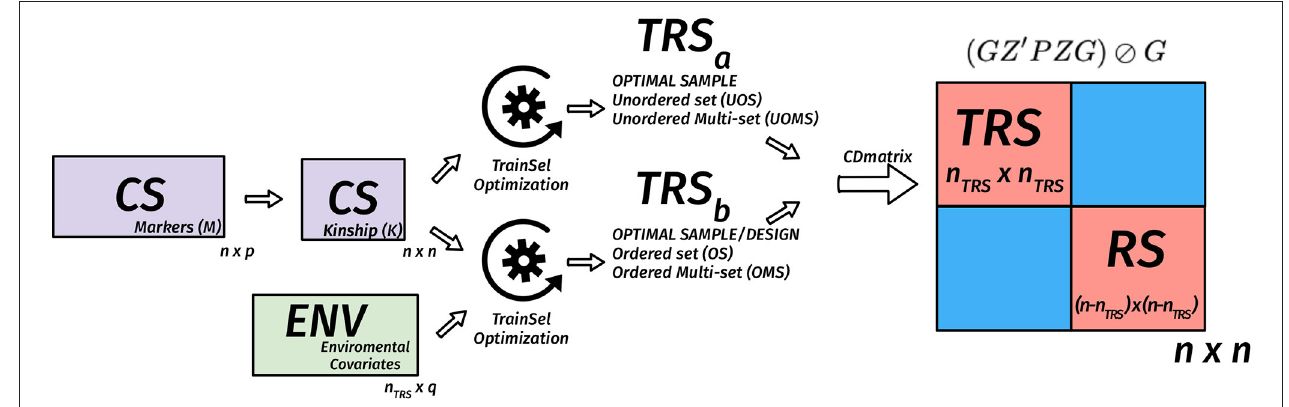
FIGURE 2 | Diagram of the matrix of the coefficient of determination (CD) criterion in the TRS optimization for unordered and ordered experiments for the un-targeted case. We assume that we have n genotypes in the candidate set, n TRS genotypes are selected to the TRS. In this case, the n × n kinship matrix is used to calculate the n × n CD matrix for a given TRS, then the mean CD is calculated based on certain diagonals that correspond to TRS or remaining set (RS). The optimization algorithm is used to find the best TRS. When provided with a design matrix that has heterogeneous rows, then we are also looking for a design in addition to the selection of a TRS. In this case, both the kinship matrix and the n TRS × q environmental covariates matrix are used to calculate the n × n CD matrix for a given TRS, then the mean CD is calculated based on certain diagonals that correspond to TRS or RS. The optimization algorithm is used to find the best TRS and best design with this